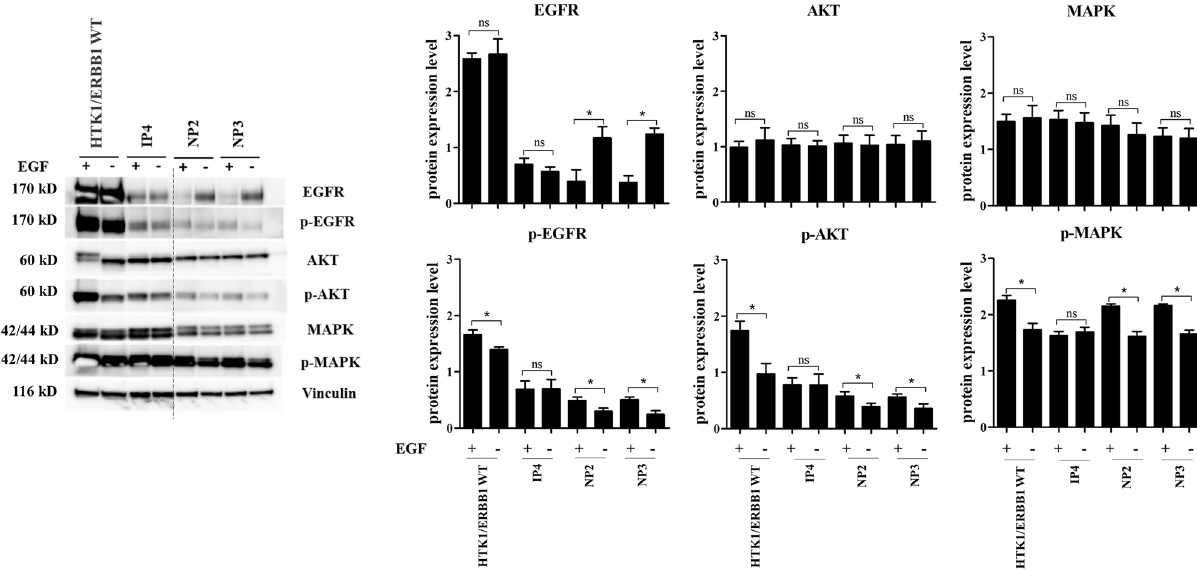
Figure 6. Constitutive activation of the EGFR signaling pathway in the IP4 cells harboring the P772_ H773insPYNP mutation in EGFR exon 20. The cells were cultured in triplicate 6-well plates, starved overnight in serum- and EGF-free FYAD medium, then incubated in the presence or absence of 50 ng/ml of EGF for 30 min prior to harvesting cell lysates and analyzed by western blotting. The total and the phosphorylated levels of EGFR, AKT, and MAPK were detected by the antibodies described in Methods (left panel), and the intensities of individual bands were indicated by bar graphs (right panels). Note that the phosphorylated levels of EGFR, AKT, and MAPK were increased in both presence and absence of EGF in culture medium in IP4 cells. Asterisks indicate a statistically significant difference ( p < 0.05), and “ns” indicates not